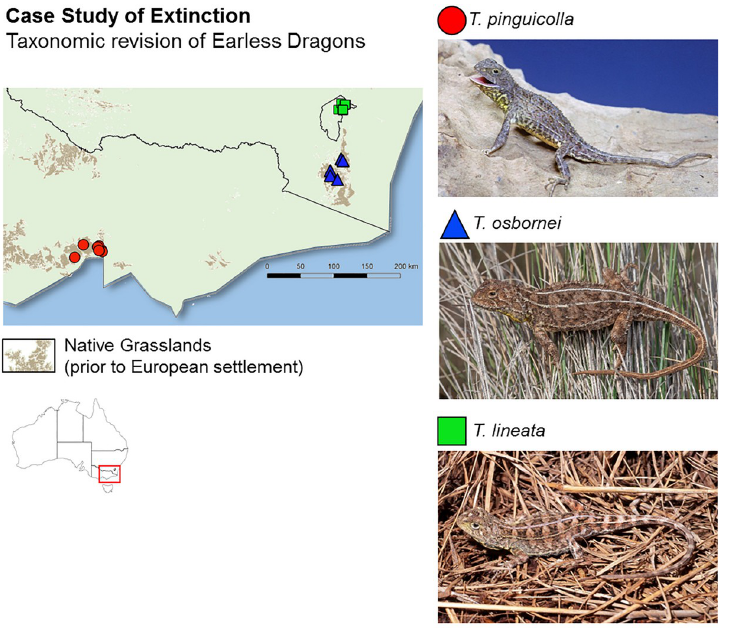
Fig 3. Earless Dragons—A case study of taxonomic research in groups containing undescribed species with a high probability of being threatened. The Grassland Earless Dragon ( Tympanocryptis spp.) species complex occurred in the temperate native grasslands of south-eastern Australia (main map), grouped within a single species ( Tympanocryptis pinguicolla ), which was listed as Endangered on the IUCN Red List. However, available genetic and genomic data provided strong evidence that a full taxonomic revision was warranted [10,22].As a result, T . pinguicolla is now thought to have been restricted to the Melbourne region and may represent the first extinction of a reptile on mainland Australia. Two new species, Tympanocryptis osbornei and Tympanocryptis lineata , were described and have a high probability of a threatened status. Full details of this case study and an example ROI assessment are provided in the supplementary materials (S1 Text, S3 Fig, S3 Table). Image credits: T . pinguicolla (F. and C. Collet); T . osbornei and T . lineata (S. Wilson). Map layer: Bioregional Assessment Source Dataset (https://data.gov.au/data/dataset/ 0cb242e2-daed-4507-a42e-73892c0941a1). Vegetation layer: pre-1750 tussock grasslands Department of Environment and Energy. 2018. National Vegetation Information System (NVIS) Version 5.1—AUSTRALIA (https://www.